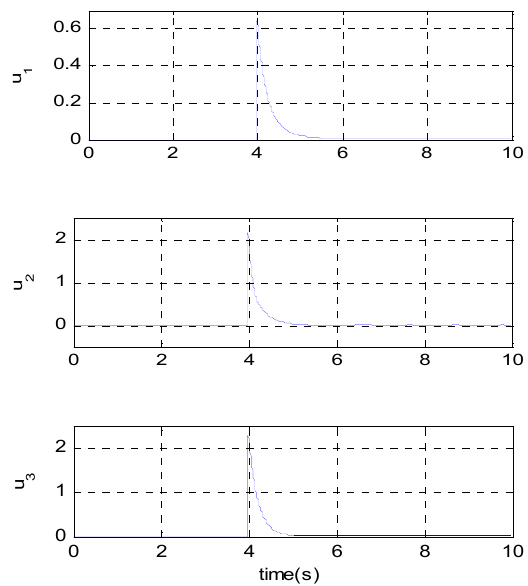
Figure 5. Control signals u 1 ( t ) , u 2 ( t ) and u 3 ( t ) .